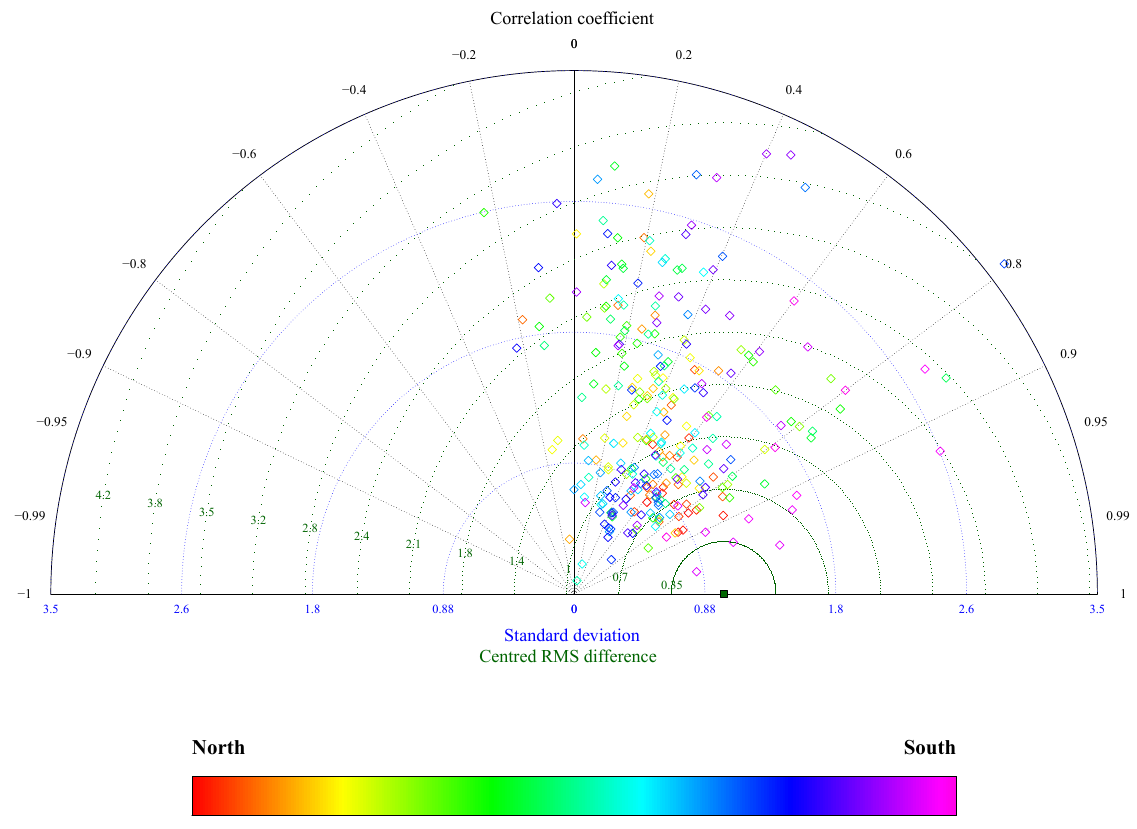
Figure 8. Comparison of simulated discharge with 287 gauges provided by ArcticNET (http://www.r-arcticnet.sr.unh.edu/v4.0/index.html) and UNH/GRDC (http://www.grdc.sr.unh.edu/index.html). Stations with basin area ≥ 10000km 2 are taken into account. Gauges are ordered from north to south (see legend